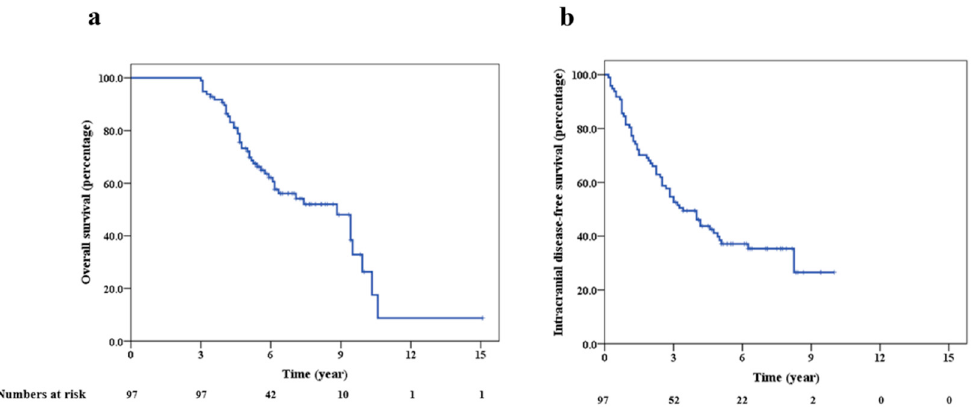
Figure 1. Kaplan Meier survival plots showing overall survival ( a ) and intracranial disease-free survival ( b ) for long-term survivors.